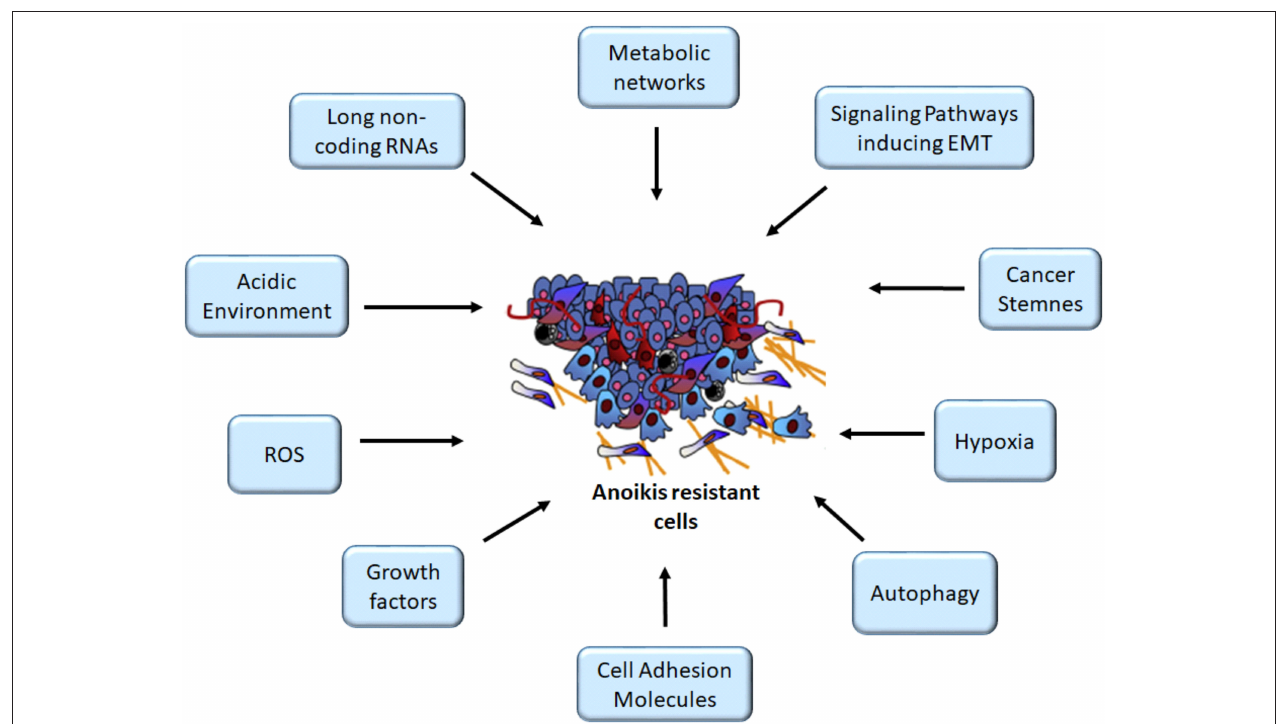
FIGURE 1 | Mediators of anoikis-resistant cells. The figure depicts several factors altering anoikis mechanism, thus enhancing cancer cell survival following detachment, an important criterion for the initiation of metastasis cascade. ROS, reactive oxygen species. Image for anoikis resistant cells was adapted from ( 11).